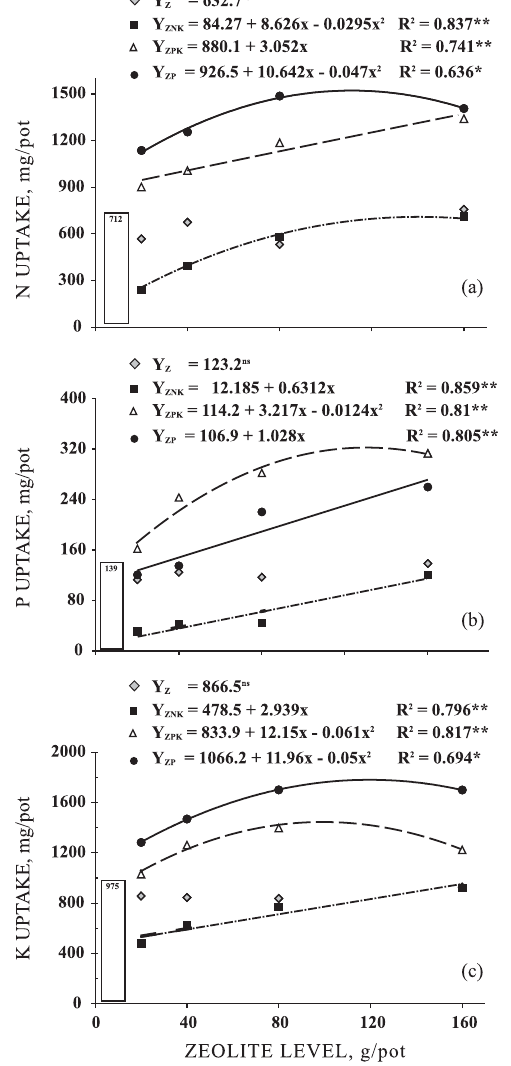
Figure 2. Nitrogen (a), phosphorus (b) and potassium (c) uptake in aboveground biomass of lettuce, tomato, rice, and andropogon grass (two cuts) plants successively grown in zeolite-enriched substrate zeolite - enriched with N, P and K. The bar indicates the control